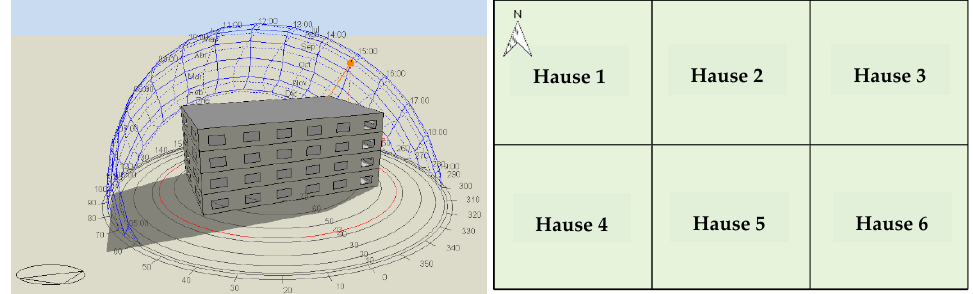
Figure 1. Distribution of reference building and housing.